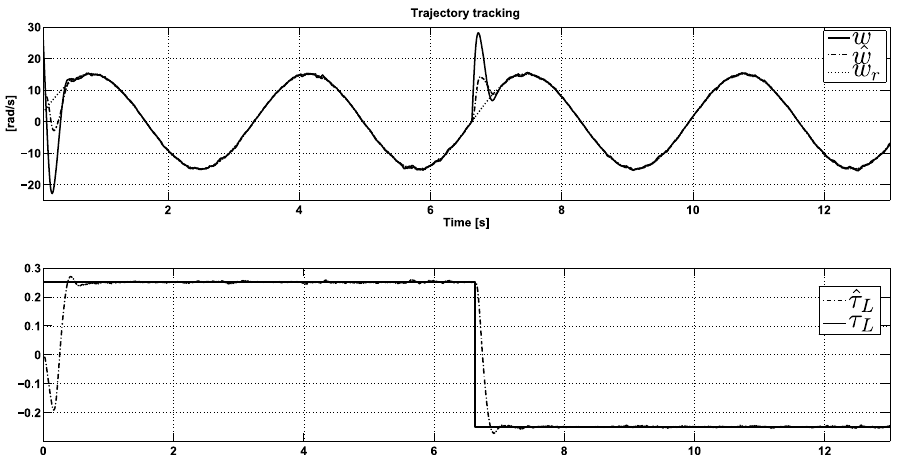
Figure 2. Variable and parameter estimations for tracking of a trajectory implemented as a smooth step.